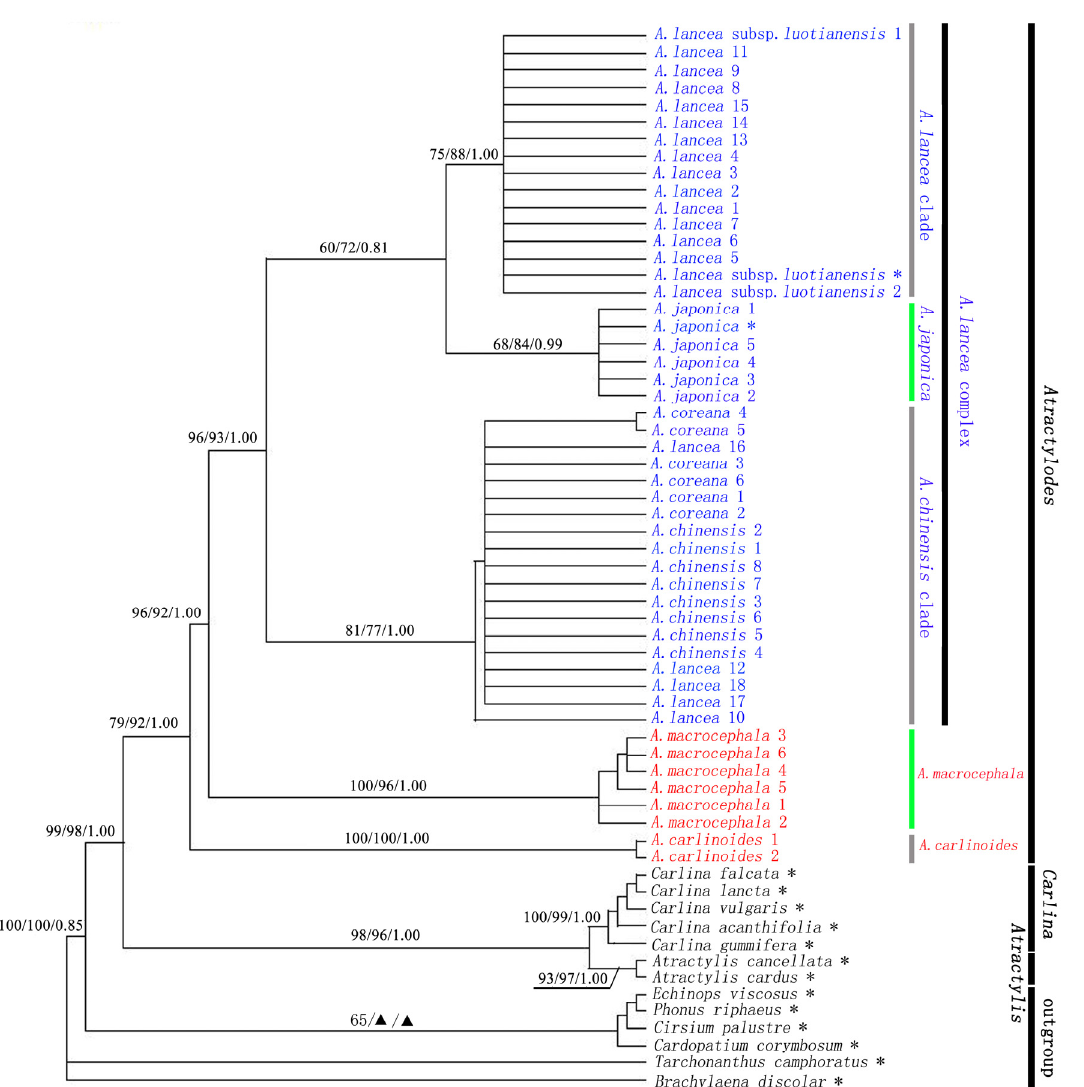
Figure 1. The 50% majority rule consensus tree from Bayesian Inference (BI) analysis of the combined ITS and trn L - F dataset; Maximum parsimony and ML bootstrap values and Bayesian posterior probabilities are shown above branches (MP/ML/BI). ▲ indicates ≤ 50% support. Taxa with * were downloaded from GenBank. Among the Atractylodes, the taxon with red color represent red flower, and the blue colored have white flower. Taxa with green color have obvious petiole, and gray colored have no